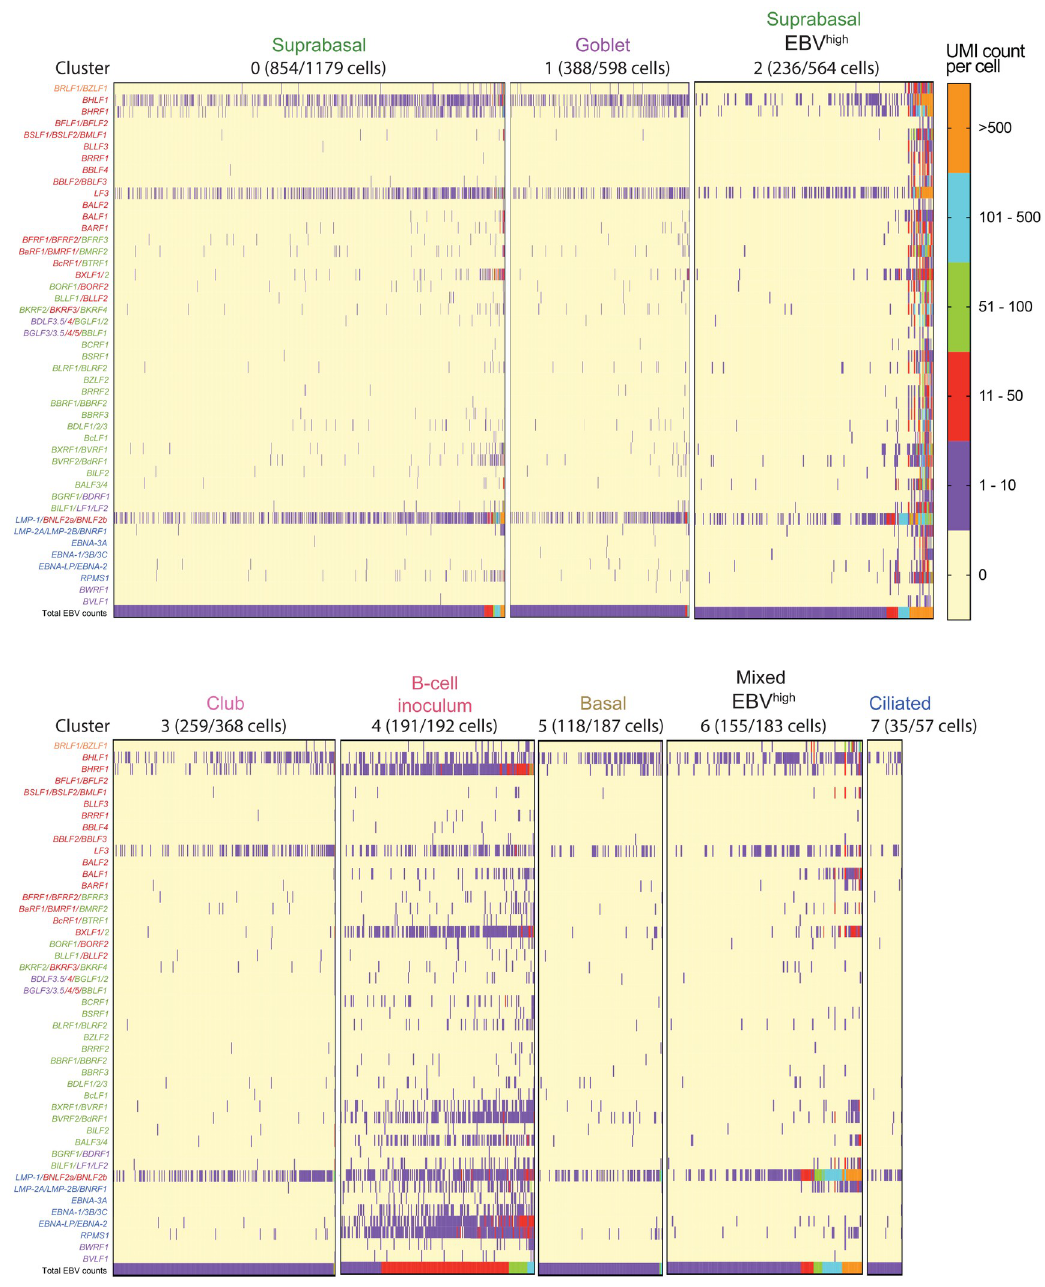
Fig 8. Distinguishing EBV gene expression profiles by cell type. Heatmaps show EBV gene expression by UMI count per cell, displayed for each cluster, for the EBV-infected pseudo-ALI culture of donor no. 4. To distinguish EBV high from EBV low cells, total EBV counts (total EBV UMI counts per cell) are shown at the bottom of each heatmap. Only the EBV-infected cells (with reads aligning to the EBV genome) are shown with the number of EBV-infected cells displayed for each cluster indicated in parenthesis. EBV genes are color-coded into lytic: immediate-early (orange)/early (red)/late (green); latent (blue); and unassigned (purple). The scRNA-seq reads were aligned to the EBV genome fused annotation.